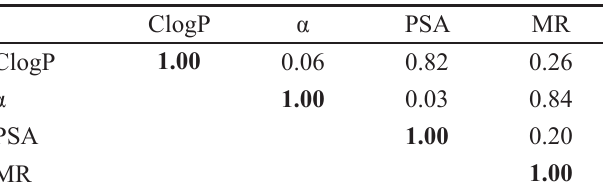
TABLE III - Linear cross-correlation matrix found for the molecular descriptors of models 4 and 5